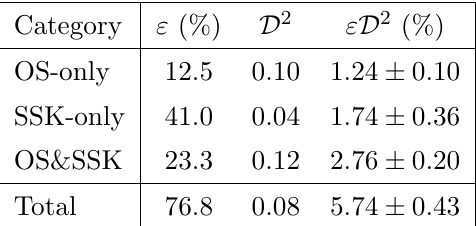
Table 2 . Tagging performance of the opposite-side (OS) and same-side kaon (SSK) (cid:13)avour taggers for the B 0 ! (cid:30)(cid:30) s